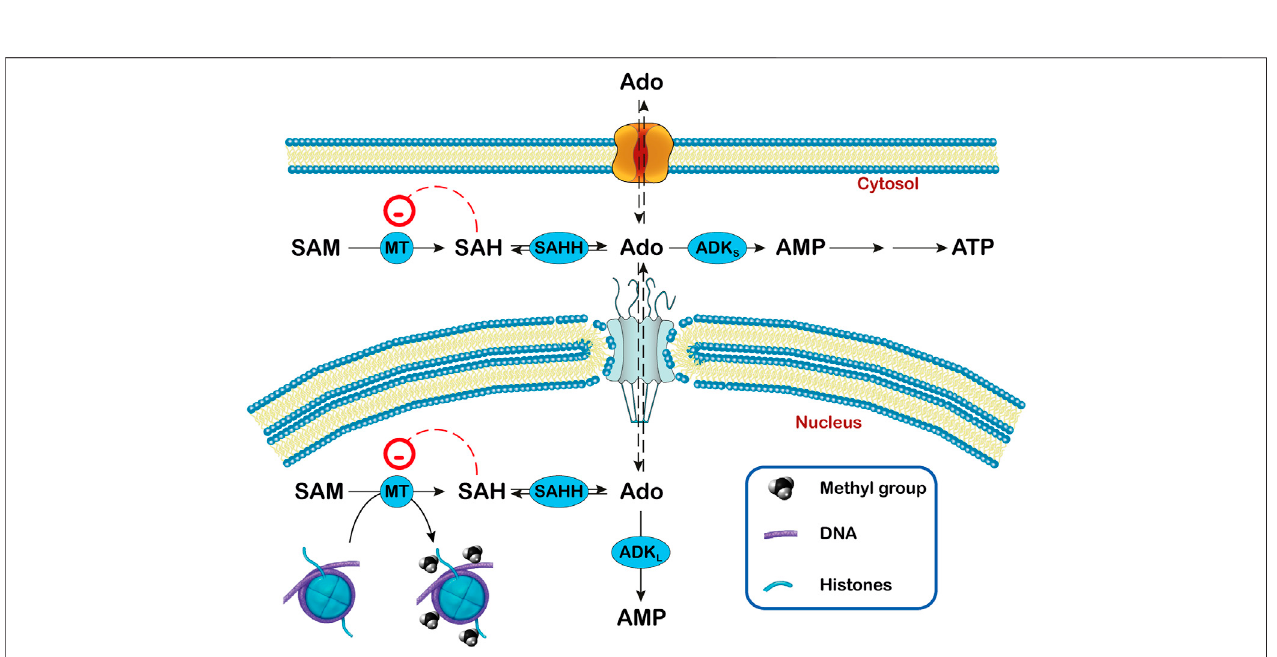
FIGURE 3 | Relationship between adenosine, ADK and transmethylation reactions in subcellular compartments. In the transmethylation reactions catalyzed by methyltransferases (MT), S-adenosylmethionine (SAM) donates the methyl group to various acceptors and is converted to S-adenosylhomocysteine (SAH), which generates adenosine (Ado) by the action of S-adenosylhomocysteine hydrolase (SAHH). In the nucleus, the methyl group can be transferred to DNA and histones. The activity of ADK (ADK S in the cytoplasm and ADK L in the nucleus) decreases the concentration of Ado and favors the transmethylation reactions. In this way, ADK L contributes to the DNA methylation in the